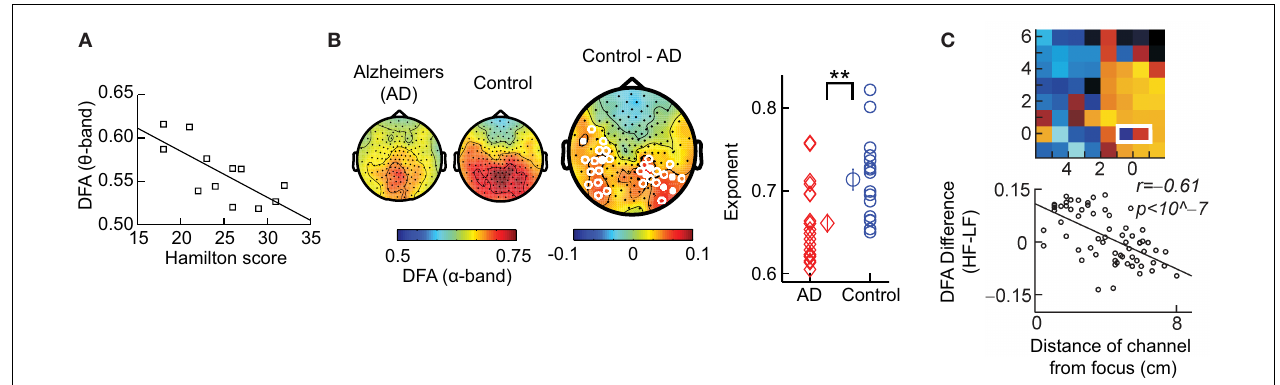
( Right ) Individual-subject DFA exponents averaged across significant channels are shown for the patients diagnosed with early stage Alzheimer’s disease ( n = 19) and the age-matched control subjects ( n = 16; Figure modified from Montez et al., 2009). (C) Difference in the DFA exponent of high frequencies (beta band) and low frequencies (alpha band) indicates the location of the epileptic focus ( white box ). Data recorded from an epileptic subject using subdural EEG during seizure-free activity (modified from Monto et al., 2007 by permission of Oxford University